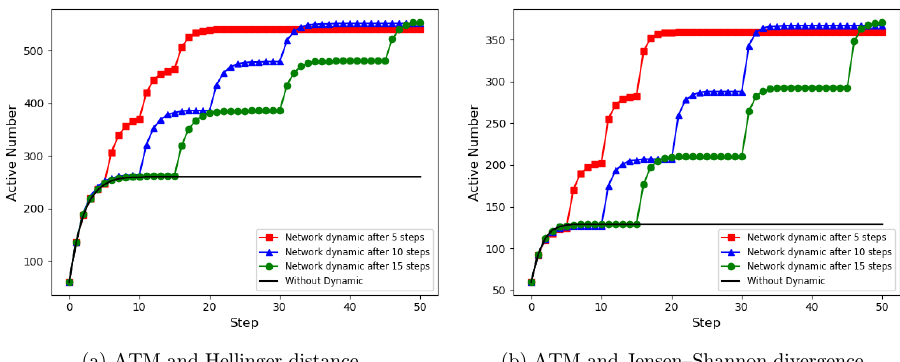
Fig. 8. Textual-Homo-IC di®usion on dynamic co-author